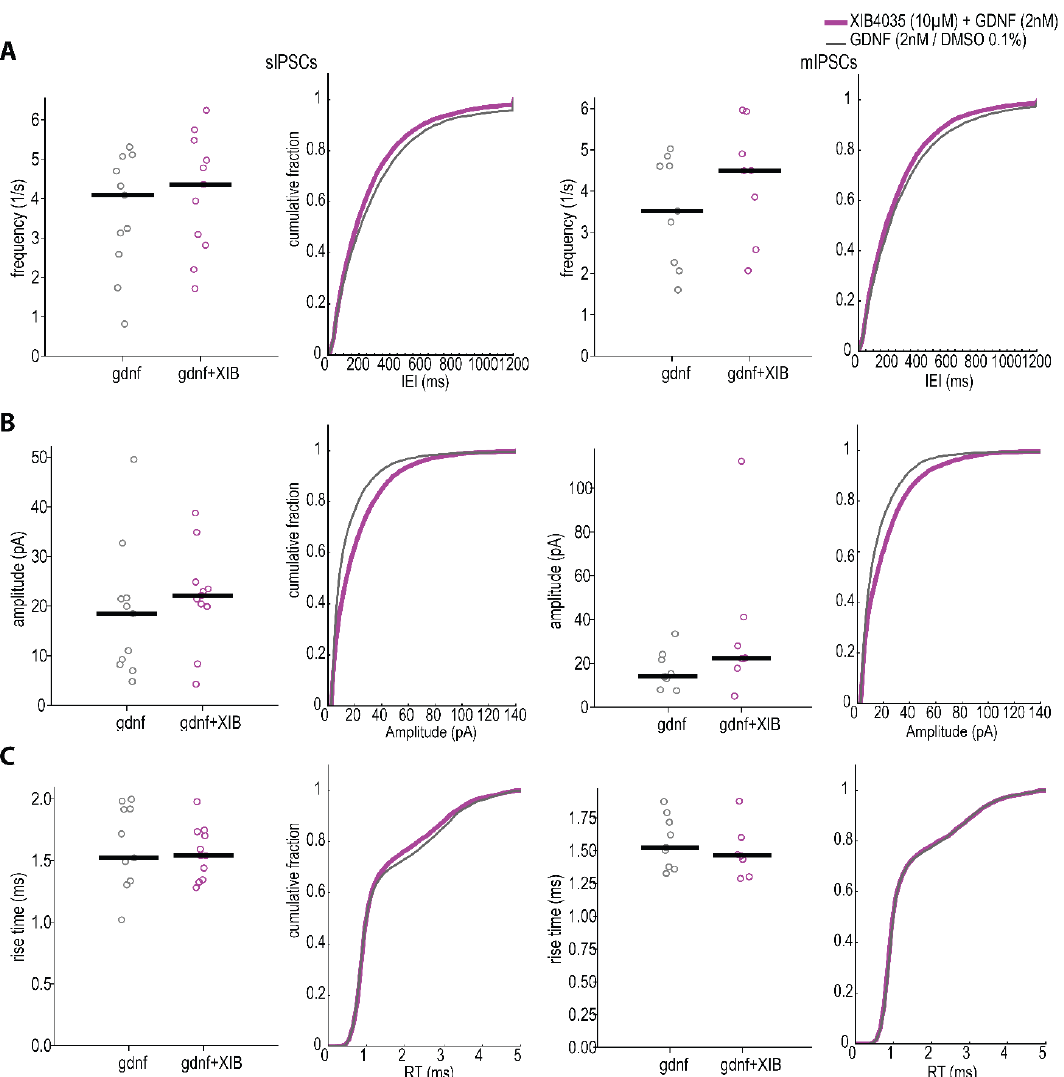
Figure 4. Quantification of Ret activation enhancement effect on inhibitory postsynaptic currents using XIB4035. ( A ) Inter ‐ event interval (K ‐ S sIPSCs p < 0.01 D = 0.068, mIPSCs p < 0.01 D = 0.088), ( B ) amplitude (K ‐ S sIPSCs p < 0.01 D = 0.144, mIPSCs p < 0.01 D = 0.166) and ( C ) rise ‐ time (K ‐ S sIPSCs p < 0.01 D = 0.032; mIPSCs p < 0.01 D = 0.034) cumulative distribution plots of spontaneous (left) and miniature IPSCs (right) from control and GDNF ‐ incubated slices (n = 511 events per cell). The line markers in the scatter plots depict the median of averages per cell. Mann–Whitney test for the averages–not significant, Kolmogorov–Smirnov test for distribution comparisons. p < 0.01.